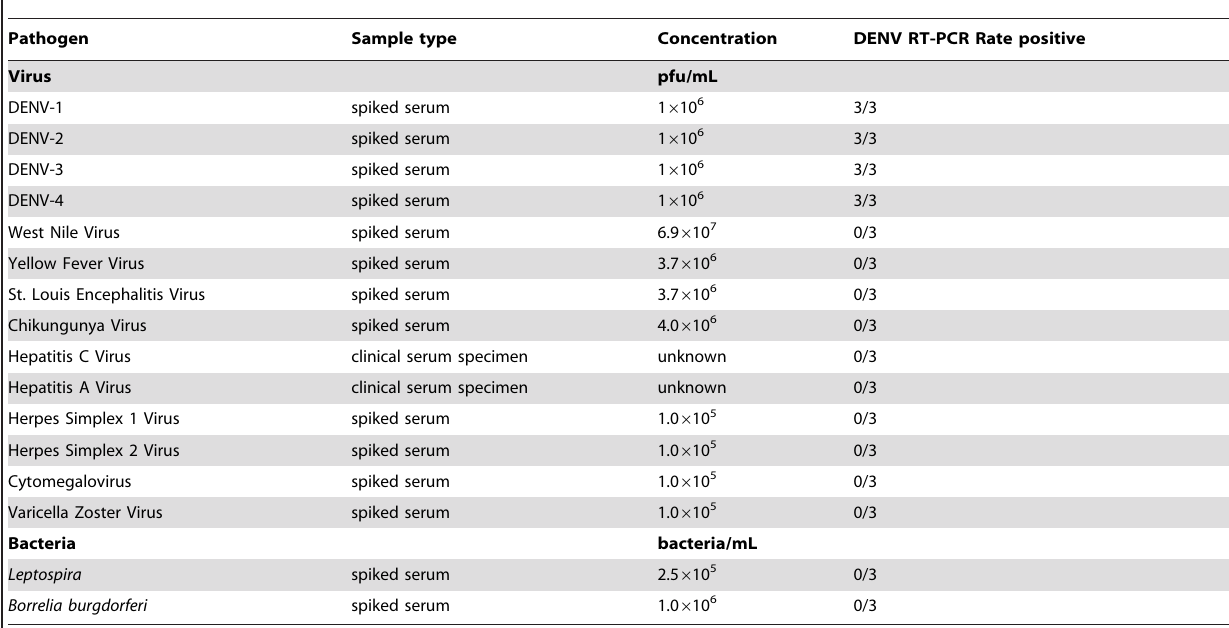
Table 3. CDC DENV-1–4 Real Time RT-PCR Assay specificity against clinically relevant concentrations of other